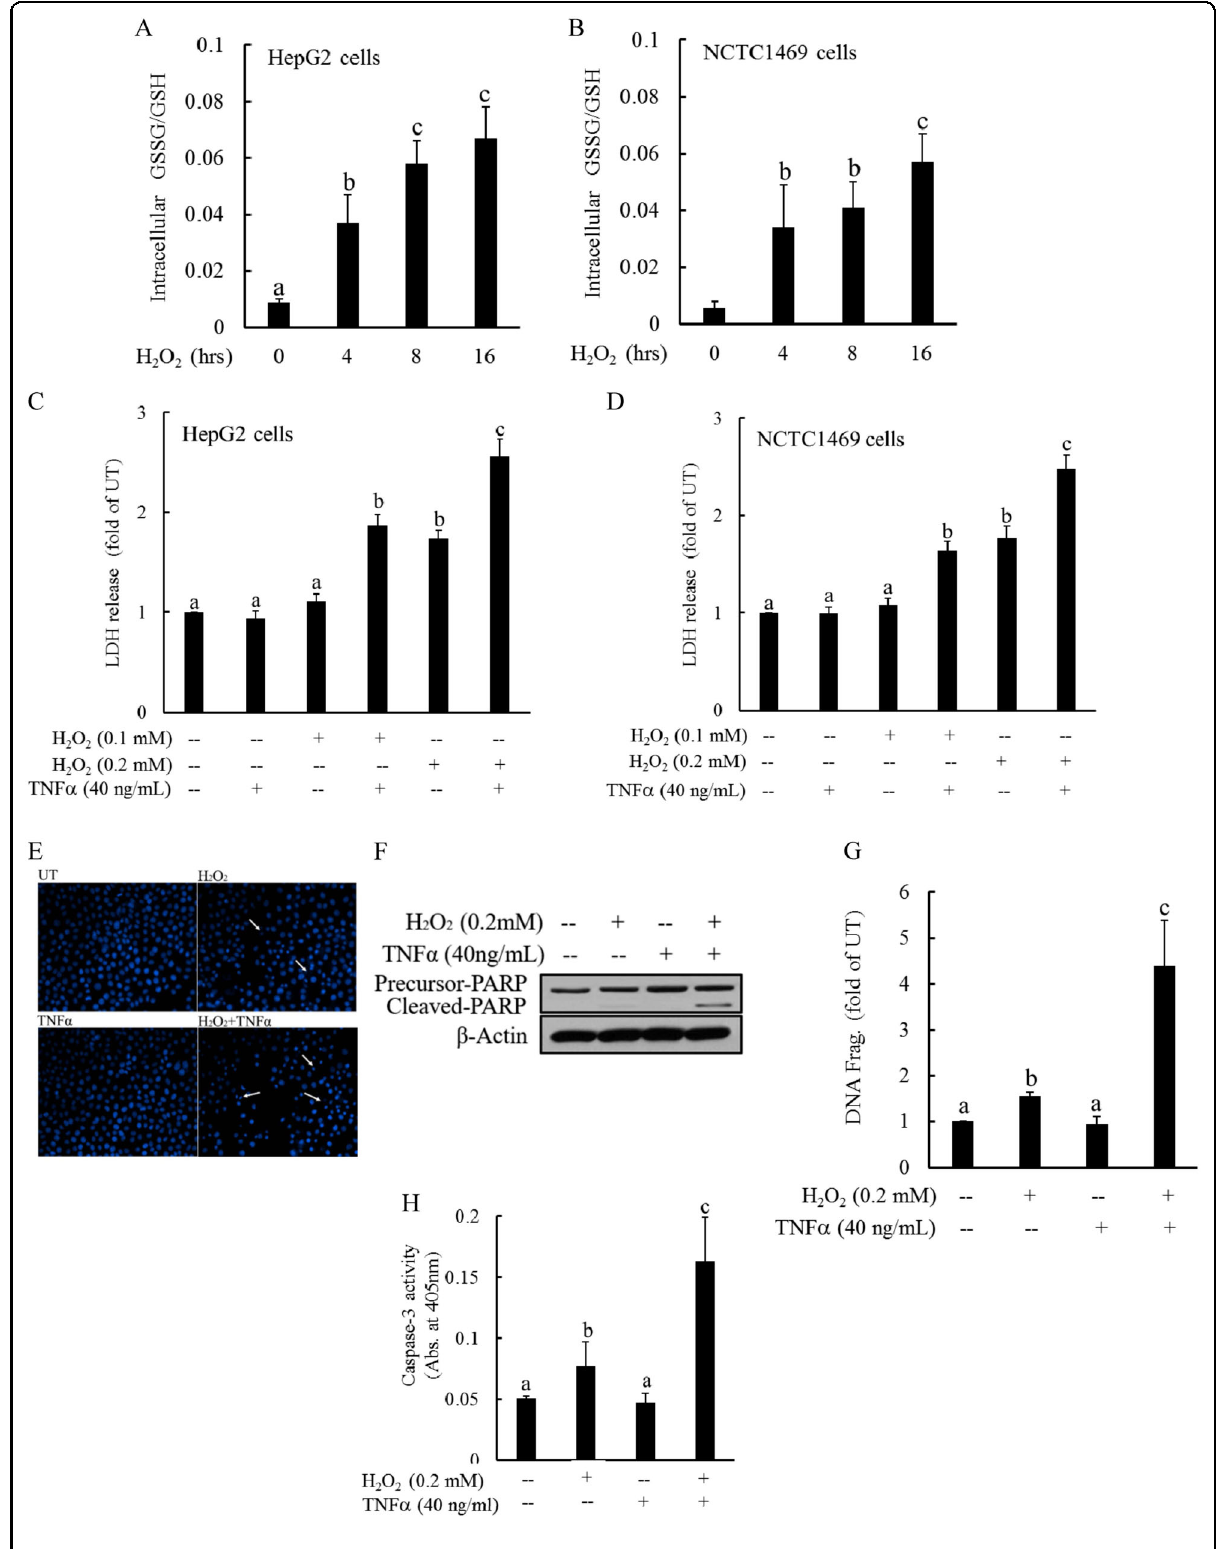
Fig. 2 (See legend on next